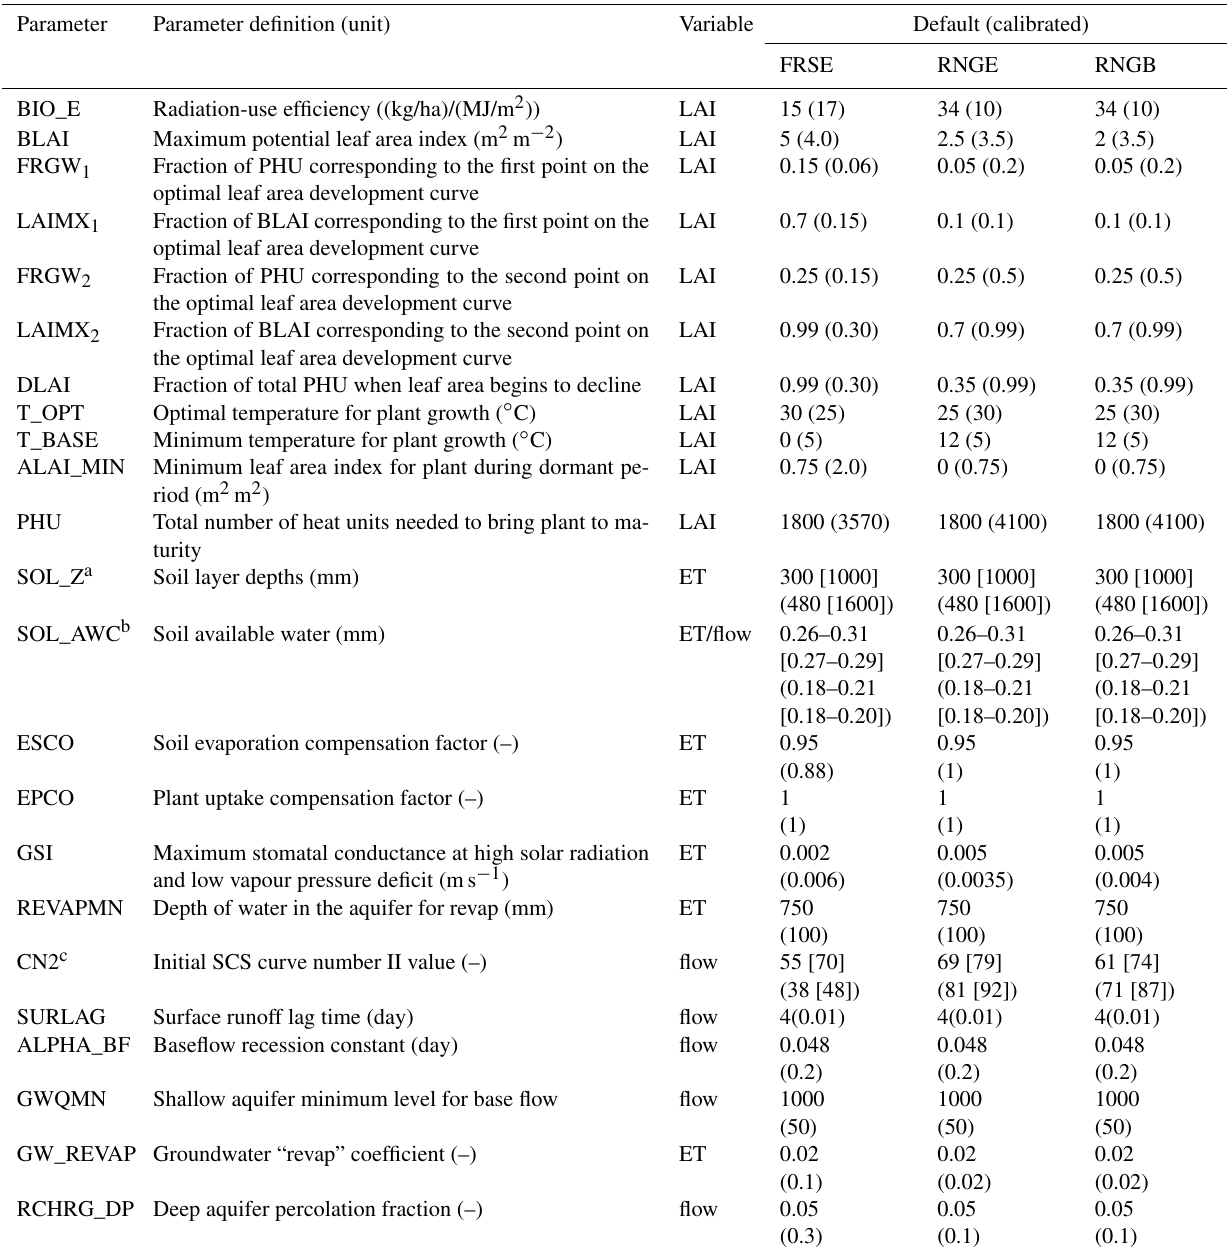
Table 2. List of SWAT parameters used to calibrate LAI, ET and streamflow with their default and calibrated values.